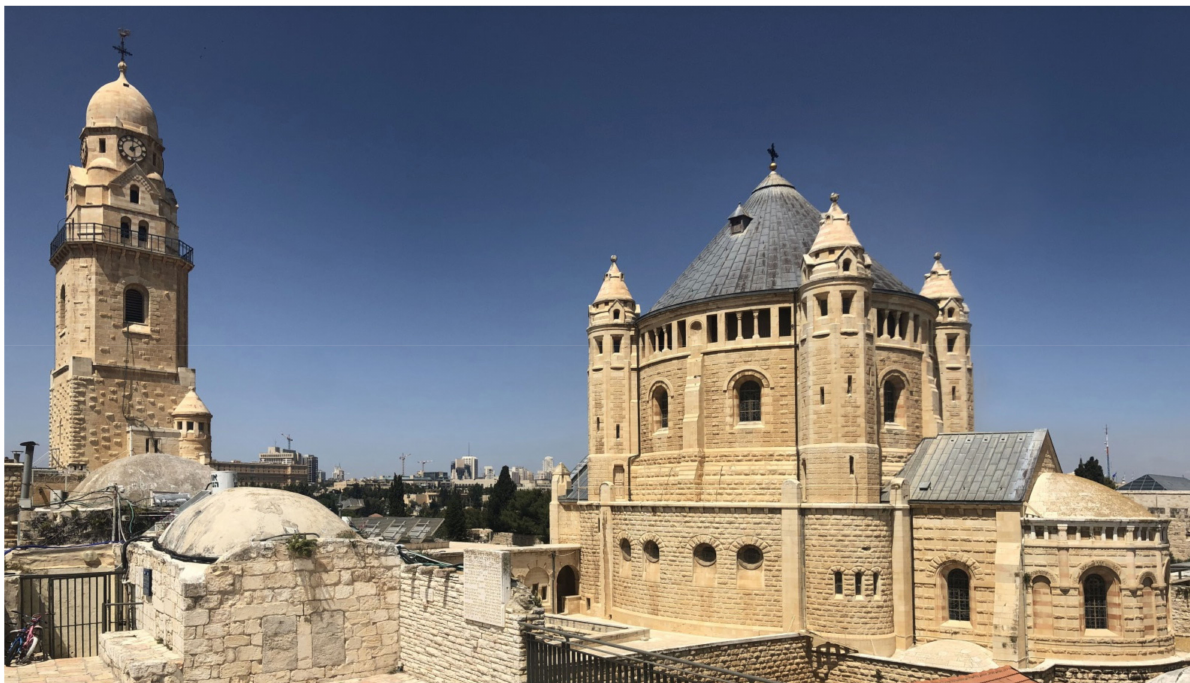
Figure 6. A close, exemplary south direction (K1) of site observation.